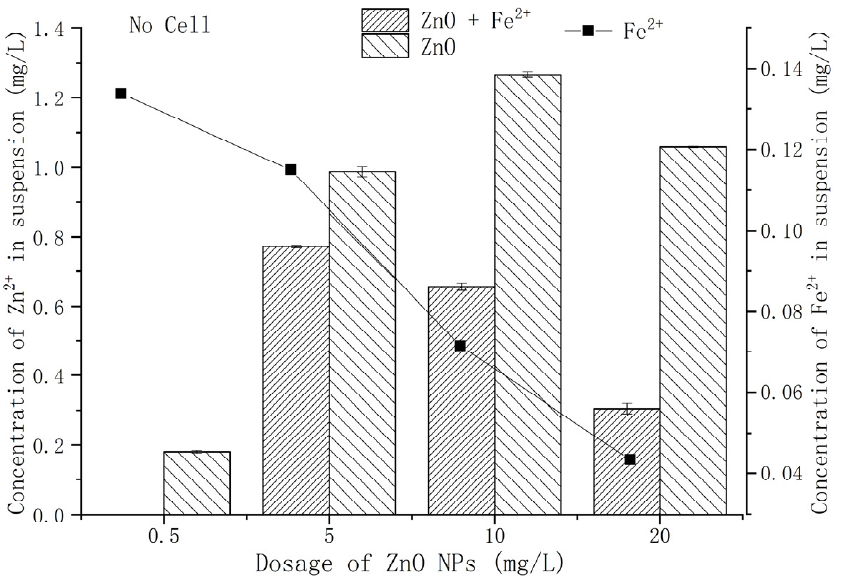
Figure 2. Effect of different content of ZnO-NPs on Zn 2+ release.